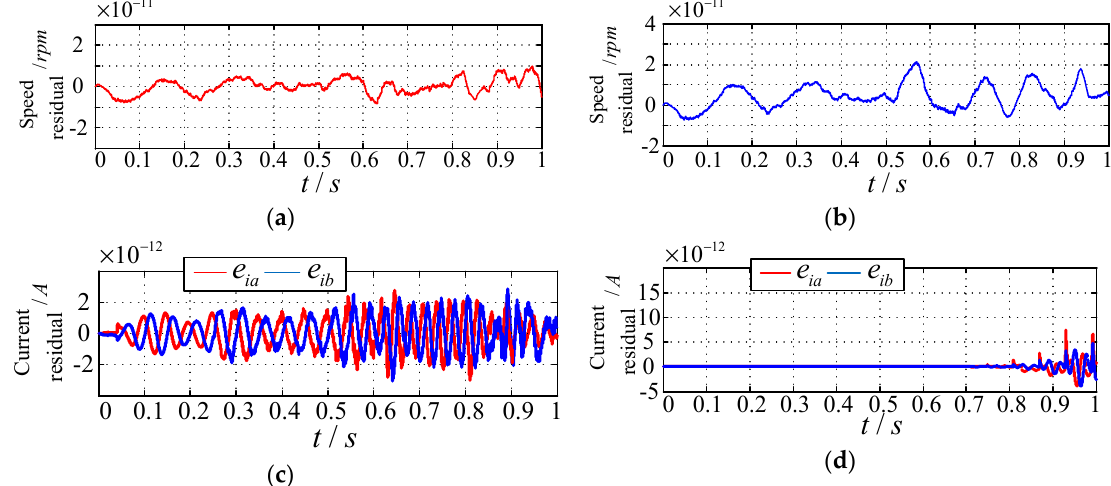
0 0.1 0.2 0.3 0.4 0.5 0.6 0.7 0.8 0.9